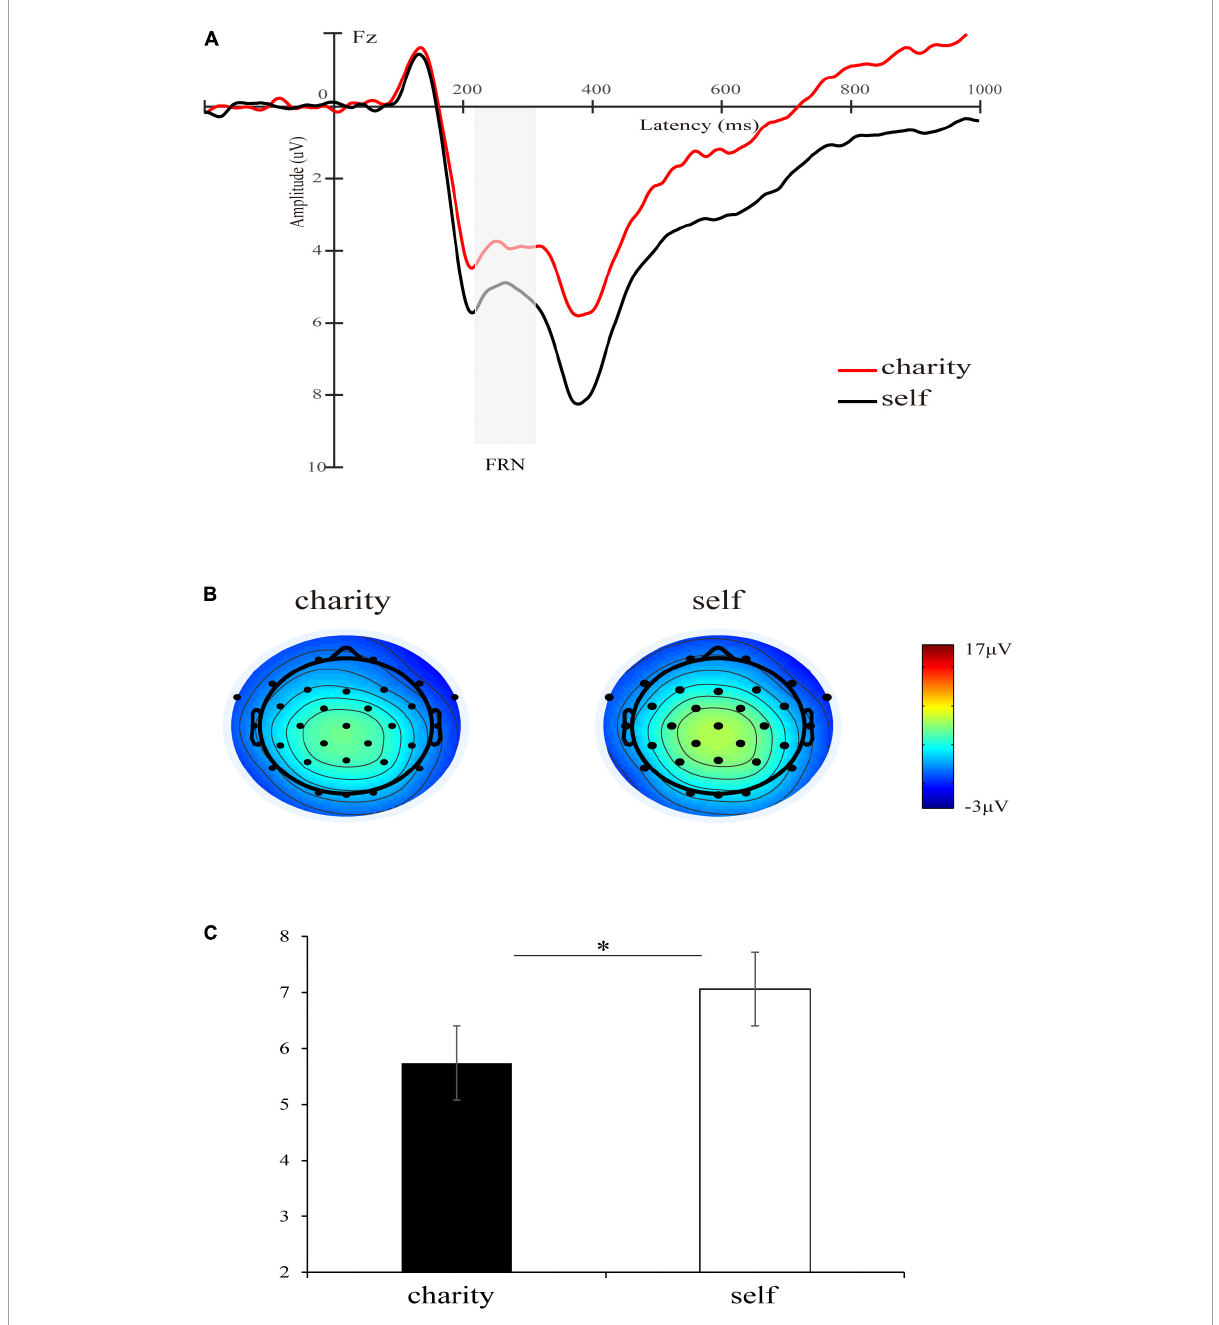
FIGURE2 (A) Grand-average ERP waveforms of FRN at Fz electrode site, the gray area highlights the 220–310 ms time window for calculating the mean value of the FRN amplitude. The red line represents the waveform of the charity and the black represents the waveform of self. (B) Topographic maps of charity and self-condition. (C) The bar graphs and standard errors show the mean values of FRN for charity and self-condition. * p < 0.05.